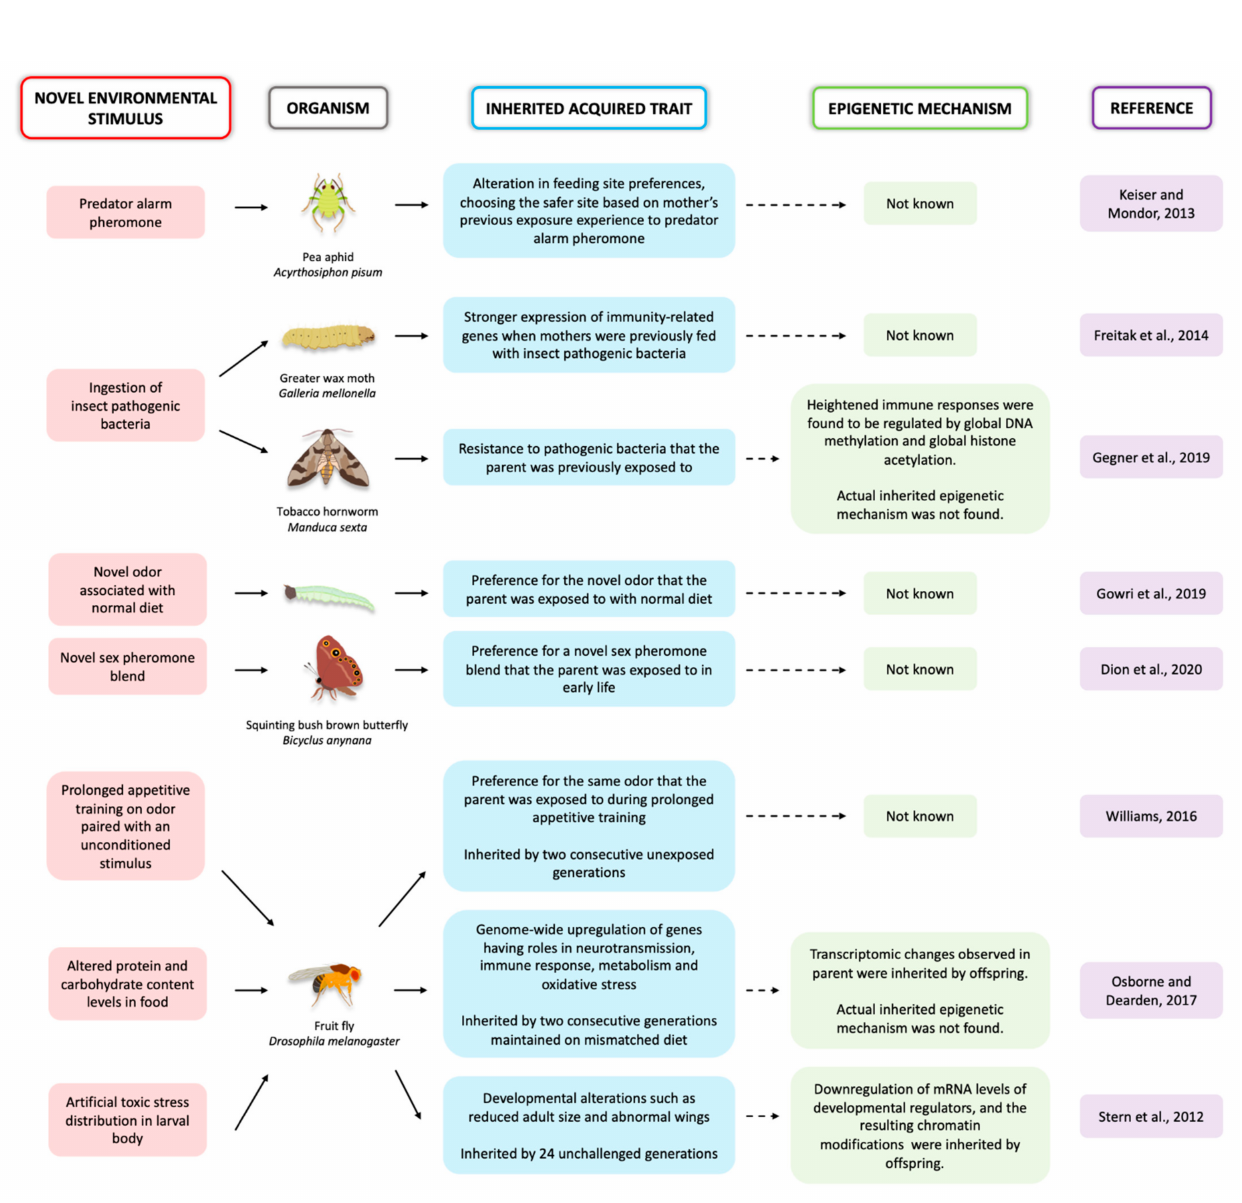
Figure 1. A summary of the research studies on the inheritance of acquired traits in insects discussed in this review